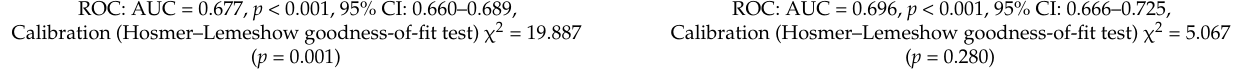
1 Diabetes 1 All variables show statistical significance for predicting 30-day mortality in multivariable logistic regression. The regression coefficient of variables significantly related to mortality ( p < 0.05) was multiplied by numbers and rounded to the nearest integer to create a score on an additive scale. Then, this score was applied to the derivation and validation group for further evaluation.